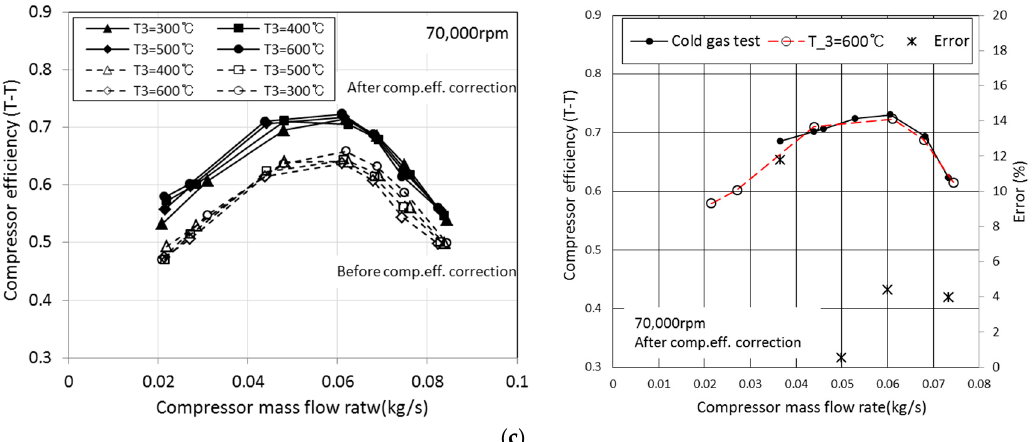
Figure 9. Graph of the compressor efficiency correction application and verification result for manufacturer’s hot gas test results. ( a ) compressor speed at 50,000 rpm; ( b ) compressor speed at 60,000 rpm; ( c ) compressor speed at 70,000 rpm.